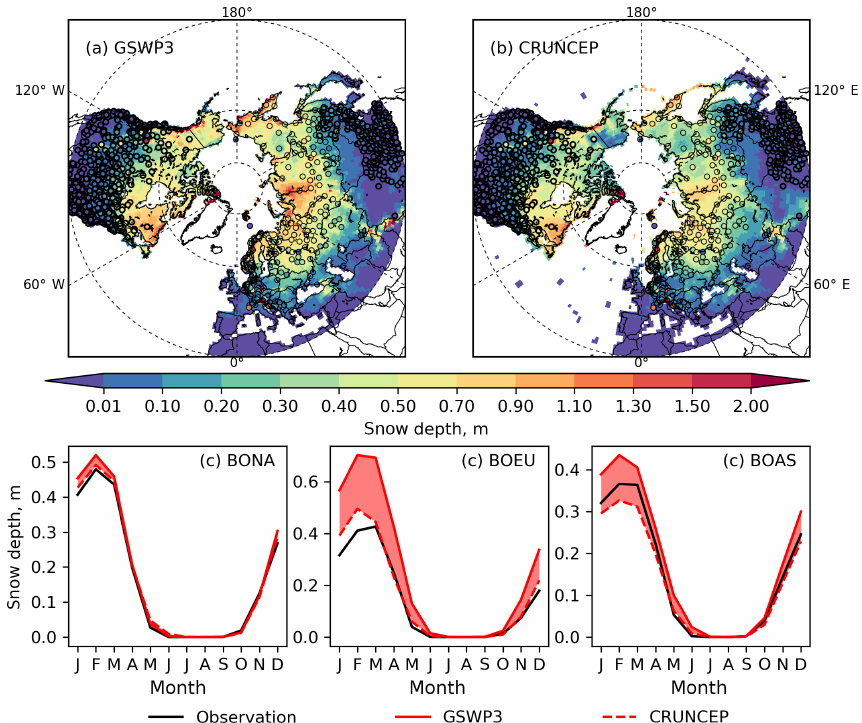
Figure 3. Maximum monthly snow depth (m) simulated (background maps) with (a) GSWP3 and (b) CRUNCEP forcings compared to observations (color filled circles), averaged over the period 1975–2005. (c) Monthly mean seasonal snow depth (m) from observation and the two simulations, averaged over the observation sites in the three high-latitude sub-regions (shown in Fig.